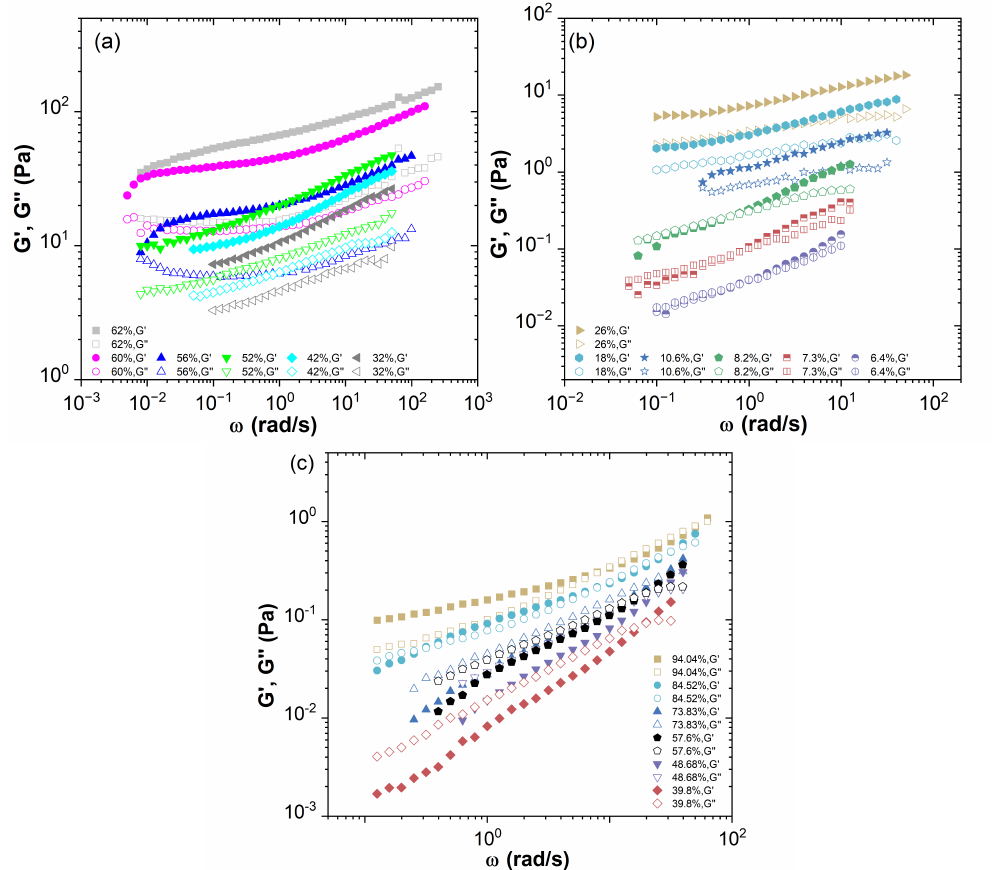
Figure 2. Plots of the storage modulus G (cid:48) and the loss modulus G (cid:48)(cid:48) against frequency obtained from small amplitude oscillatory shear experiment in the linear viscoelastic region. ( a , b ) for the Phormidium suspensions in various volume fractions and ( c ) for the human blood samples in various volume